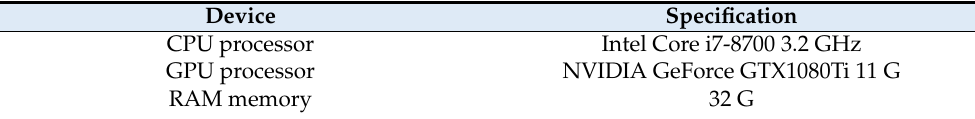
Table 3. Hardware.